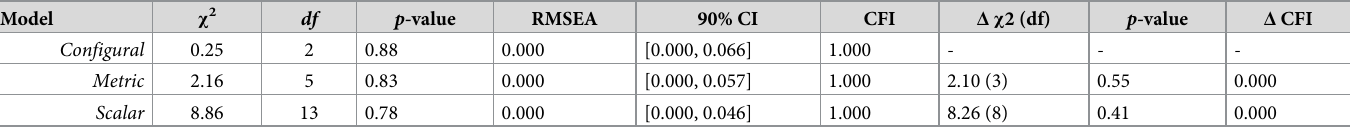
Table 3. Fit statistics for measurement invariance according to gender.